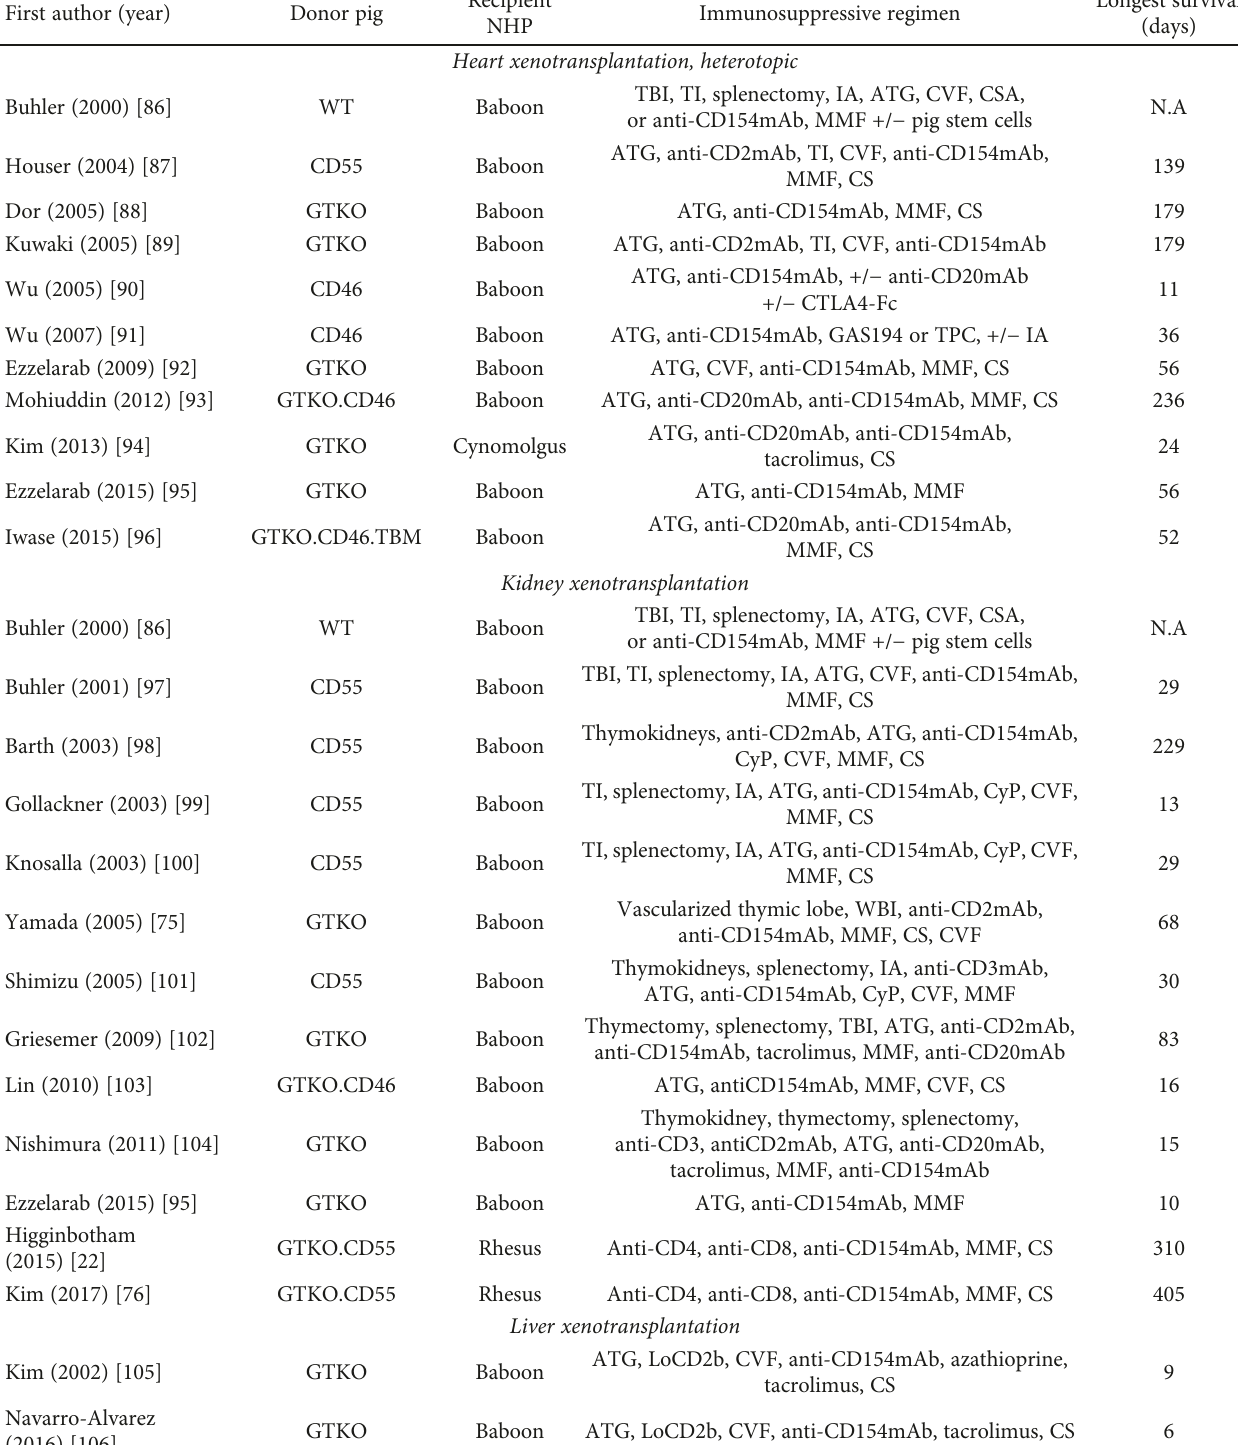
Table 2: Selected studies using anti-CD154mAb in pig-to-nonhuman primate